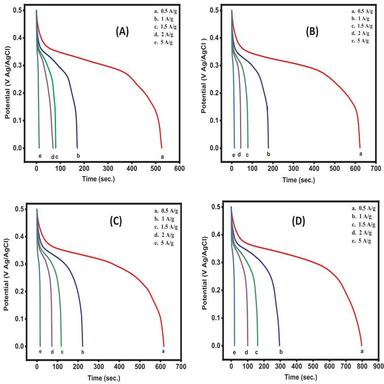
GCD discharge curves of Pr6O11 (A), Pr6O11/Mn3O4-0 (B), Pr6O11/Mn3O4-1 (C) and Pr6O11/Mn3O4-2 (D) at different current densities.